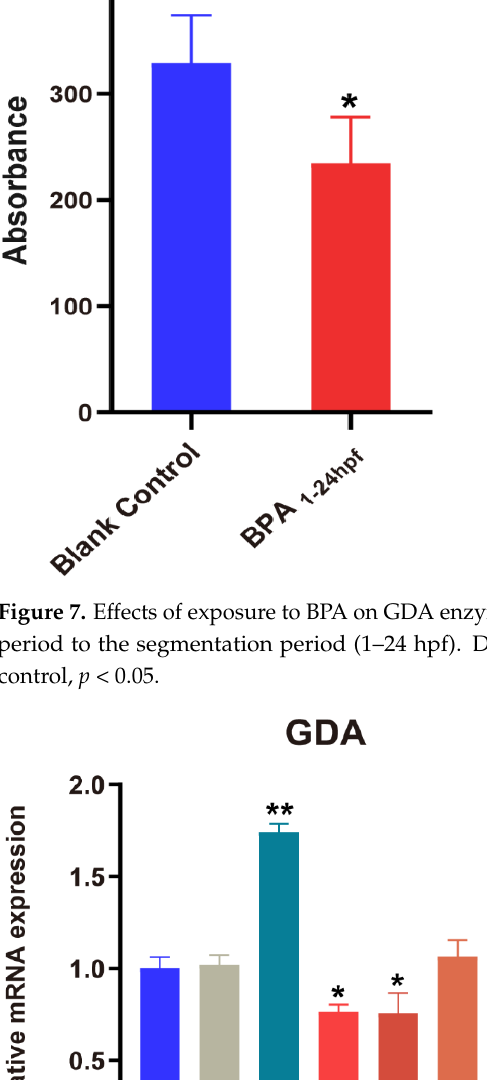
Figure 7. Effects of exposure to BPA on GDA enzyme activity in zebrafish embryos from the cleav- age period to the segmentation period (1–24 hpf). Data are the mean ± SD, *, significant from blank control, p < 0.05.